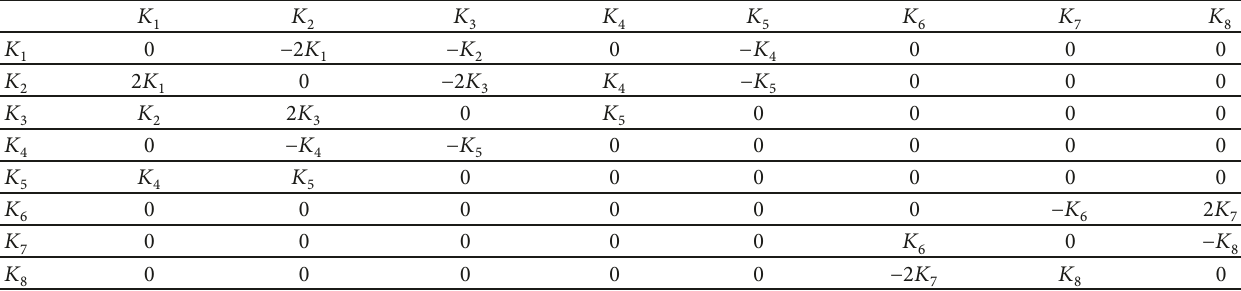
Table 1: Commutator table of G .